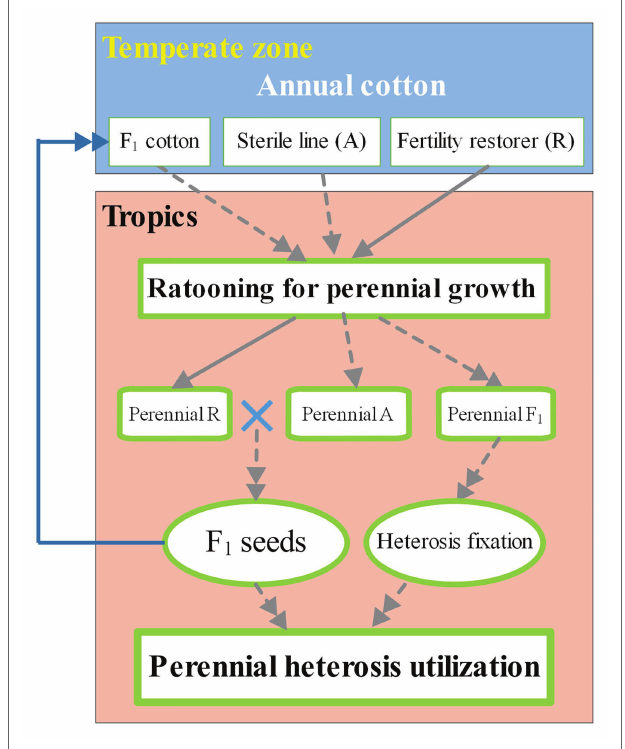
FIGURE 1 | Ratooning annual cotton for perennial heterosis utilization in tropical and near-tropical areas. The perennial heterosis utilization (green-bordered box with bold font) of annual cotton (white box) includes the production of hybrid cotton seeds generated by a male-sterile line (dotted line with a single arrowhead) and a male fertility restorer (solid line with a single arrowhead), followed by heterosis fixation of hybrid cotton (dotted line guided by double arrowheads). In subtropical regions (orange box), annual cotton from the temperate zone (blue box) can be grafted onto perennial cotton with strong cold resistance to improve winter survival. All perennial cottons types are shown in green-bordered